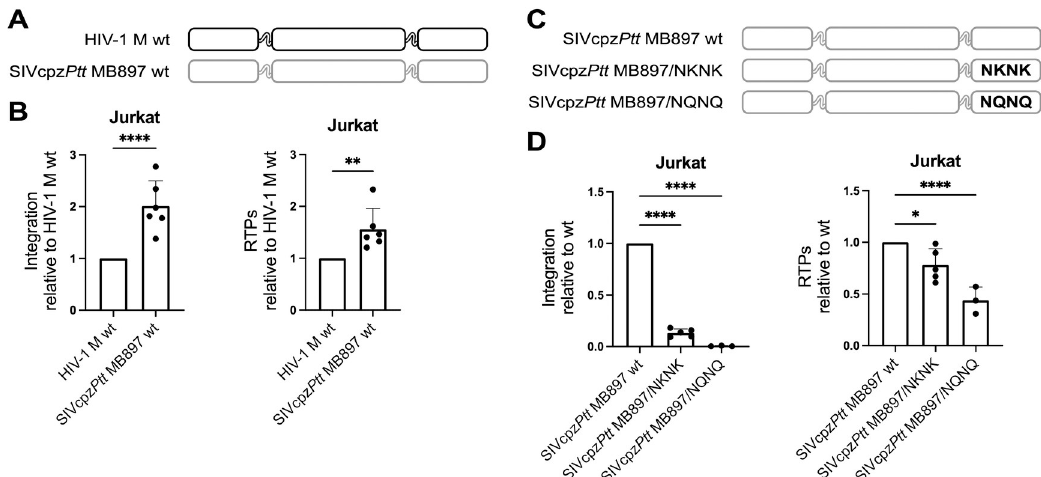
Fig 5. SIVcpz Ptt CLA motif is important for integration ( A ) Schematic representation of wt IN M and IN SIVcpz Ptt MB897. ( B ) Normalized levels of integration (left graph) and amounts of RTPs (right graph) relative to isolate M for the IN shown in panel A (n = 6). ( C ) Schematic representation of IN SIVcpz Ptt MB897 wt and the two mutants for the CLA motif positions tested for integration and reverse transcription in panel D. When mutated with respect to the sequence of the wt, the amino acids of the NOG or of the CLA motifs are shown in capital letters. ( D ) Normalized levels of integration (left graph) and amounts of RTPs (right graph) relative to SIVcpz Ptt MB897 wt (n = 6 for MB897 wt; n = 5 for SIVcpz Ptt MB897/NKNK; n = 3 for SIVcpz Ptt MB897/NQNQ). Data are shown as the average ± SD. ���� p � 0.0001. �� p � 0.01. � p � 0.05. (Two-tailed, unpaired Student’s t-test for panel B. One-way ANOVA with Tukey’s multiple comparisons correction for panel